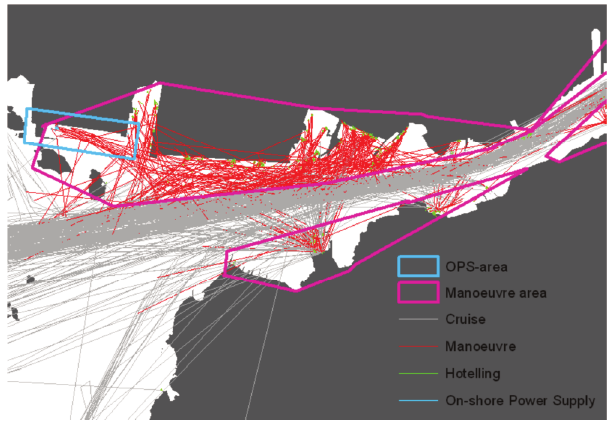
Fig. 1. Ship mode of operation in Swedish city – Göteborg [4]